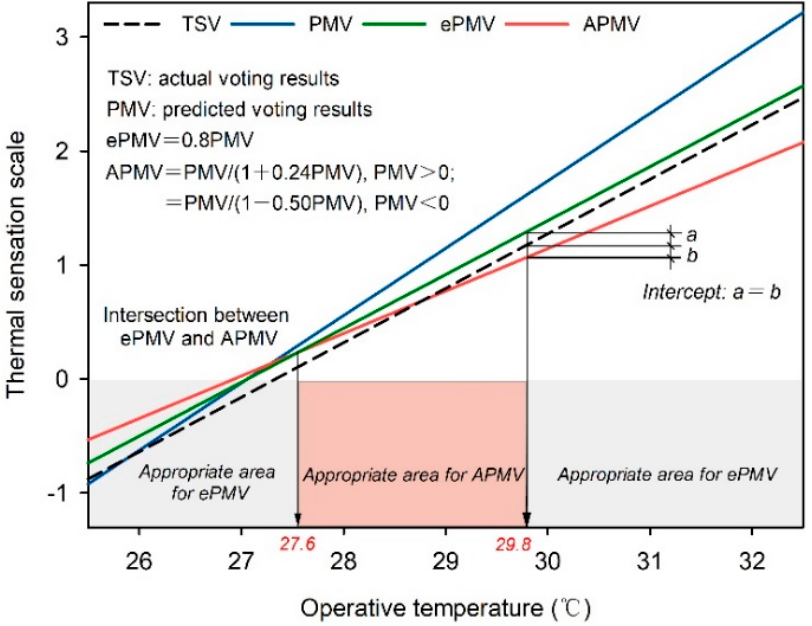
Figure 15. Comparison of TSV (this study) with previous adaptive predicted models.